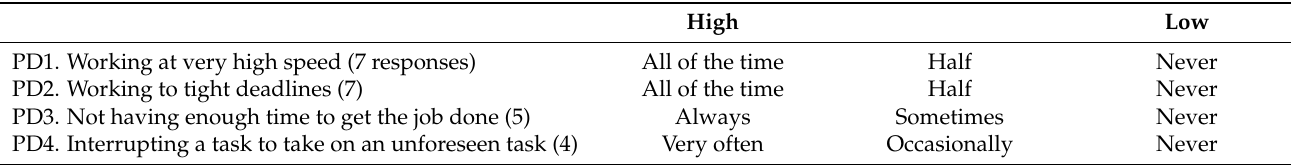
Table A1. Psychological demands (4 items).